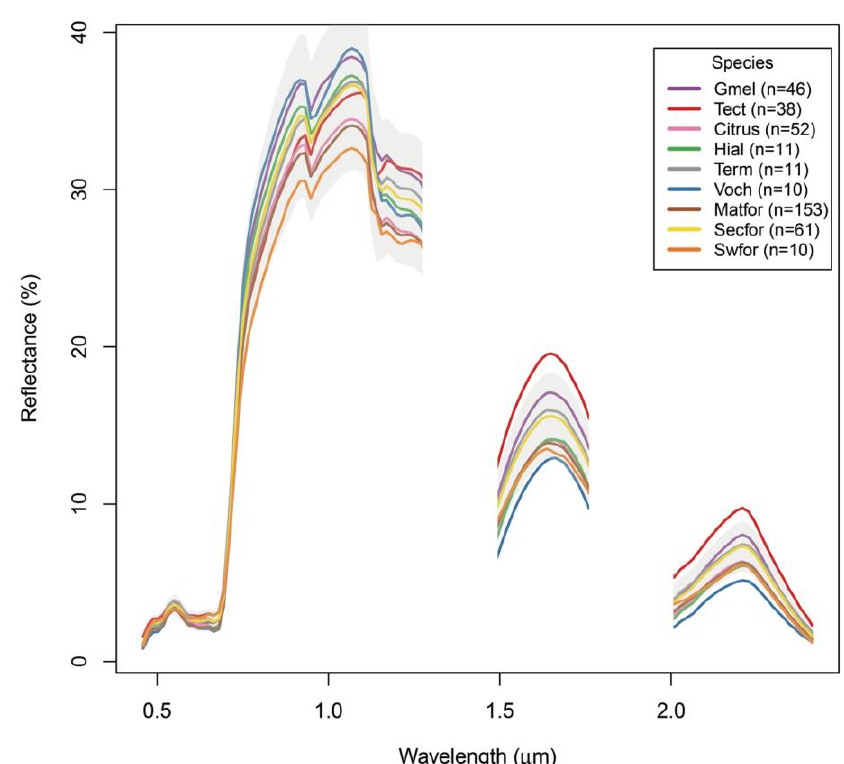
Figure 4. Mean hyperspectral reflectances for the forest classes in this analysis, derived from the HyMap imagery at the training data locations. Class sample sizes are shown in the legend; see Table 2 for class name acronyms. The gray polygon represents one standard deviation above and below the yellow secondary forest class (abbreviated here as